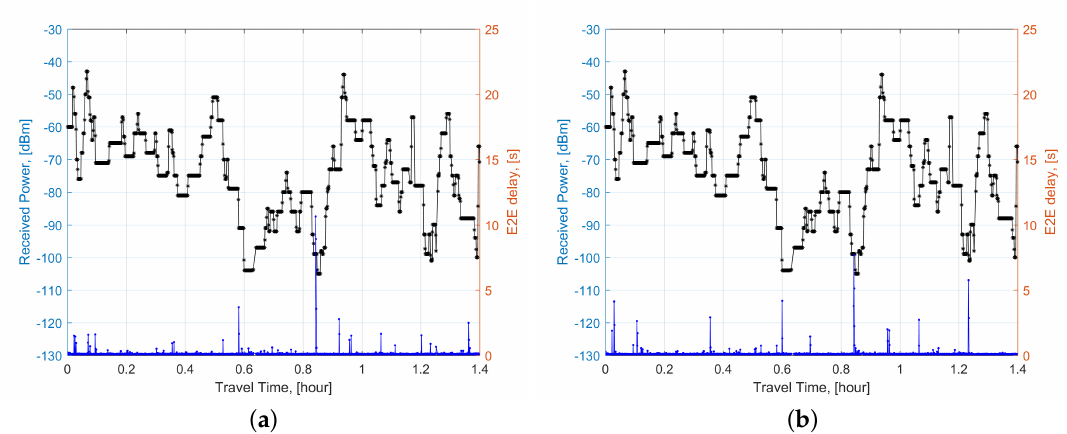
Figure 11. Example of E2E delay generation based on a given received power profile and for a single technology (i.e., WCDMA